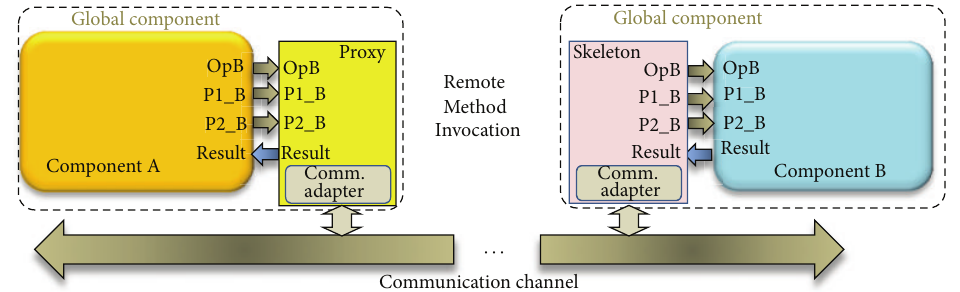
Figure 2: Hardware object adaptation for Remote Method Invocation.